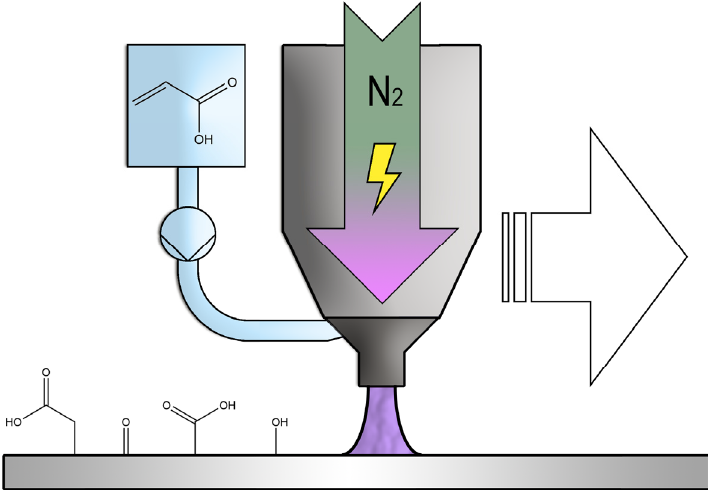
Figure 1. Diagram of the experimental setup for plasma treatment at atmospheric pressure in the presence of acrylic acid.